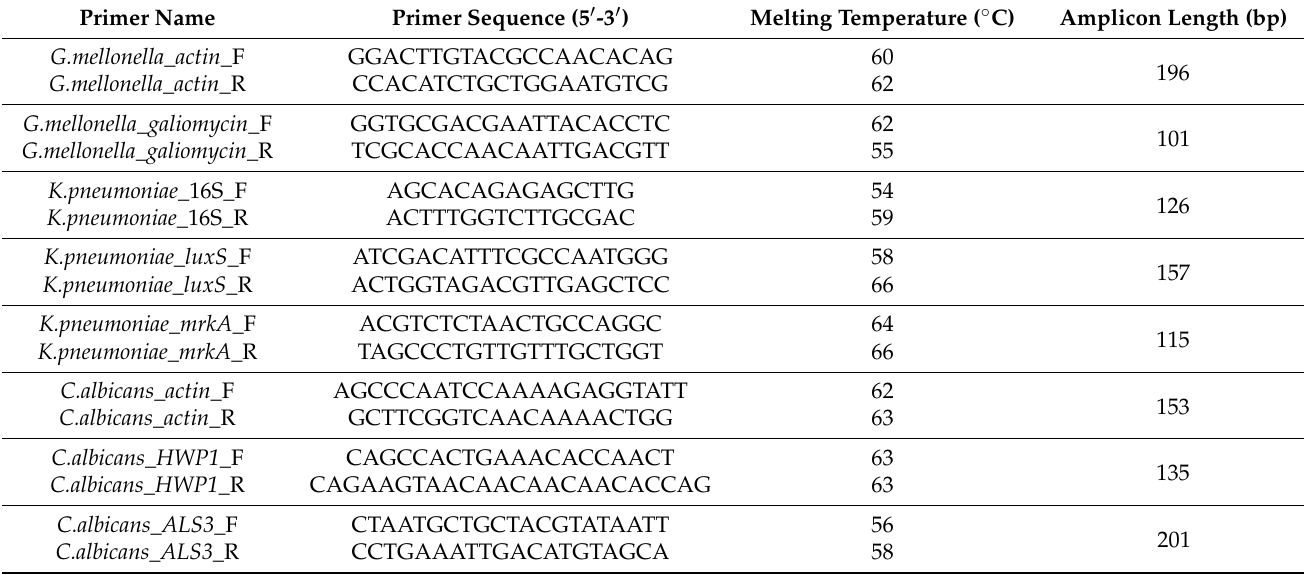
Table 1. Primers used in this